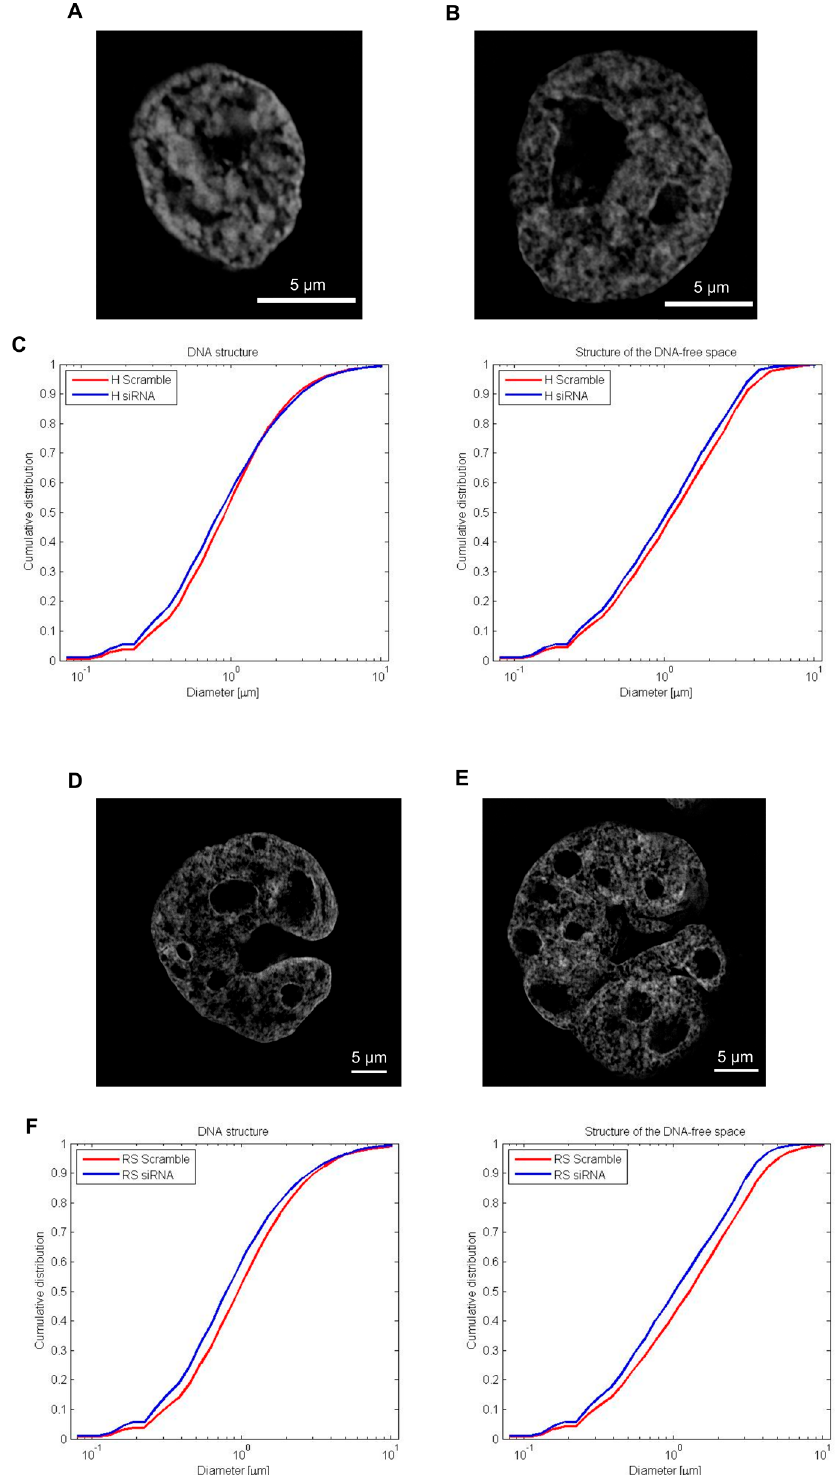
Figure 7. Granulometry analysis of siRNA lamin A/C cells and Scramble cells: ( A ) SIM image of Scramble H cell; ( B ) SIM image of siRNA H cell; ( C ) Measurements of the size distribution of DNA structure and structure of the DNA-free space in SIM images of Hoechst (33258) stained nuclei of 30 H cells from three independent experiments; ( D ) SIM image of Scramble RS cell; ( E ) SIM image of siRNA RS cell; ( F ) Measurements of the size distribution of DNA structure (H: p = 0.26; RS: p < 0.001) and structure of the DNA-free space (H: p = 0.37; RS: p < 0.001) in SIM images of Hoechst (33258) stained nuclei of 30 RS cells from three independent experiments. Two-sided, two-sample Kolmogorov–Smirnov test was used to determine statistical significance.